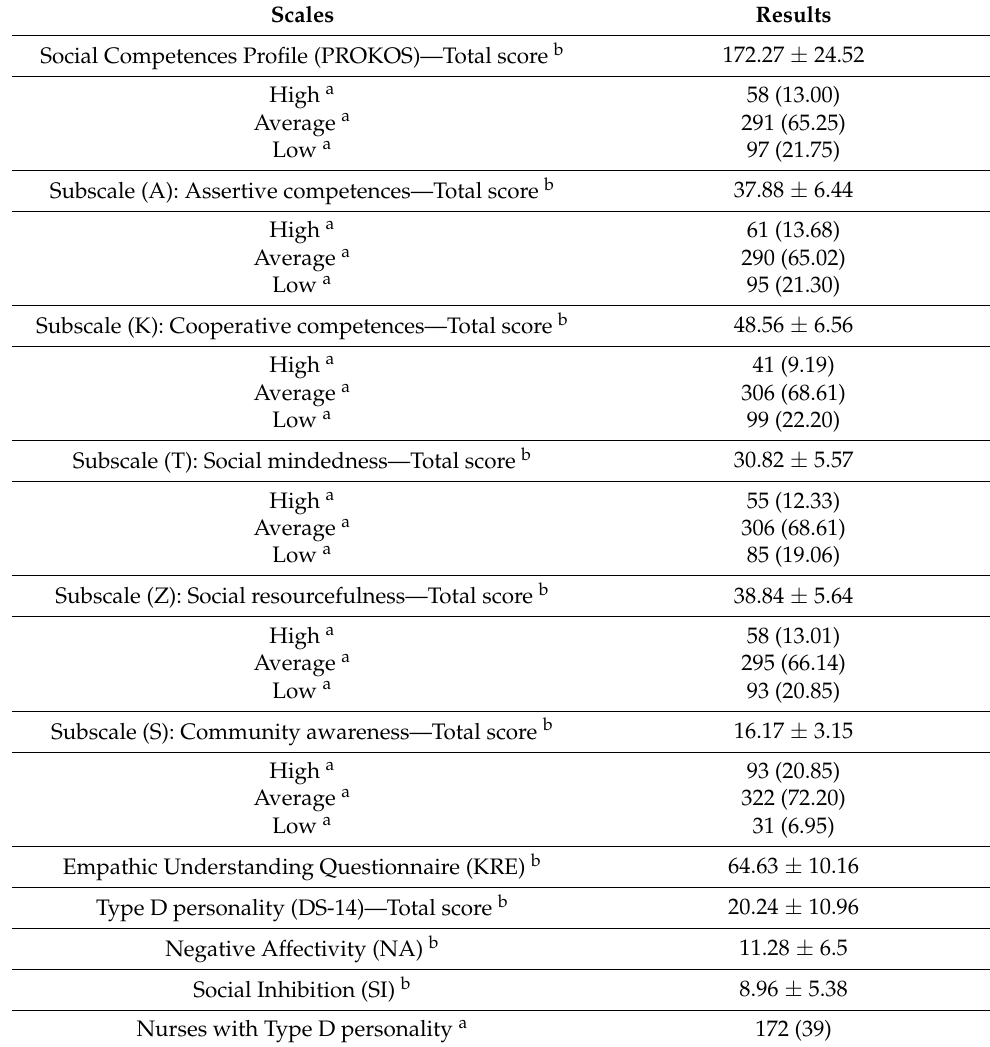
Table 1. Distribution of analysed features in